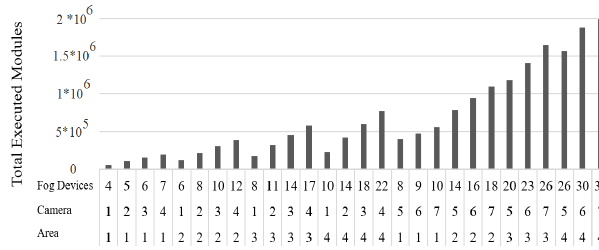
Figure 3. Total executed modules versus FD